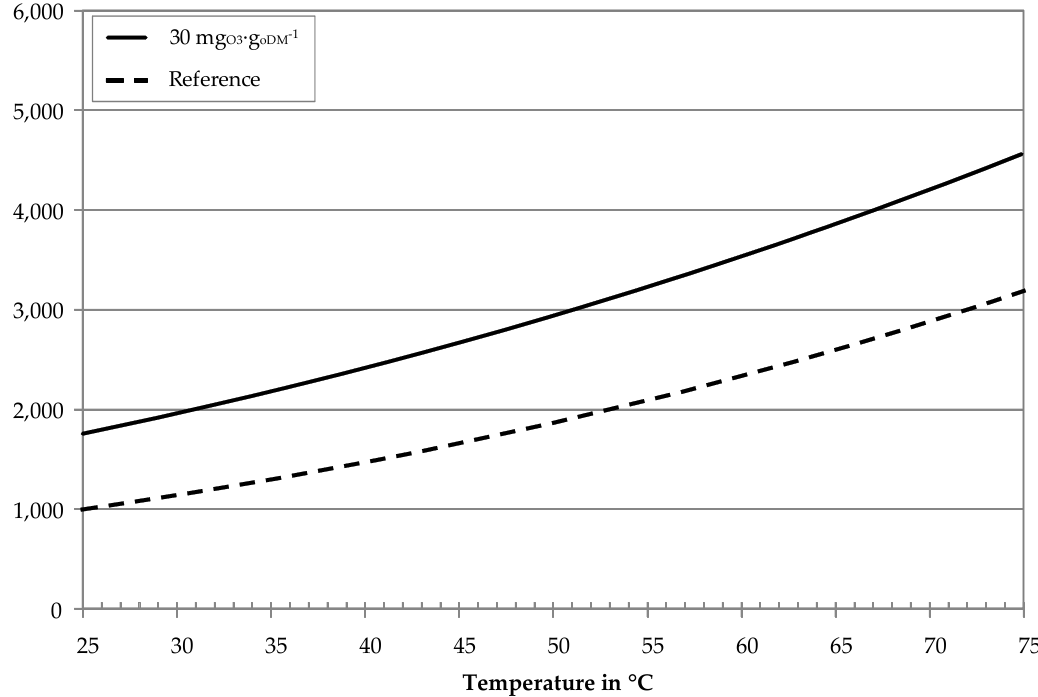
Figure 8. Calculated Reynolds numbers of digestate centrates with ozone treatment and without (reference) as a function of temperature, v = 4.6 m∙s −1 , d = 3.3 mm, rheological parameters according to Table 2.